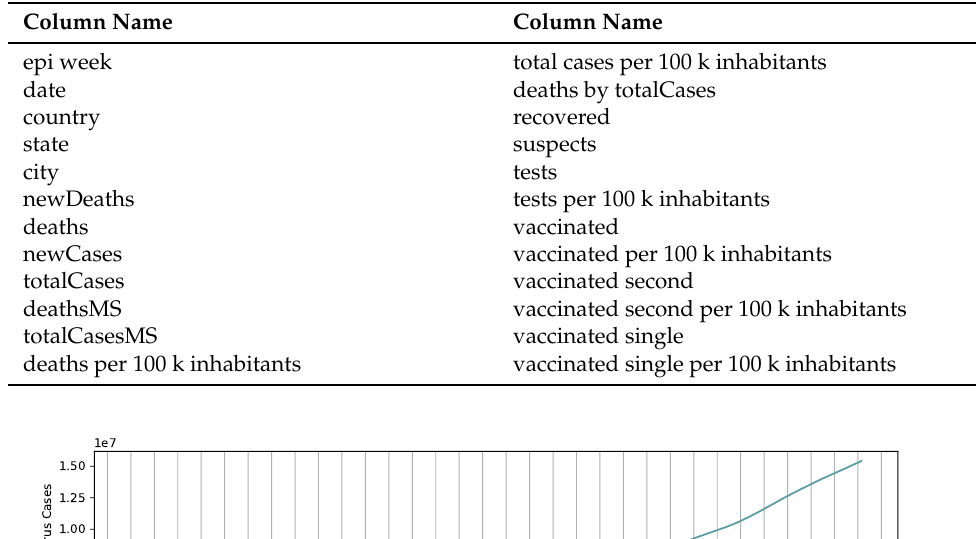
Table 1. List of all column names contained in the open-access dataset of COVID-19 [17].